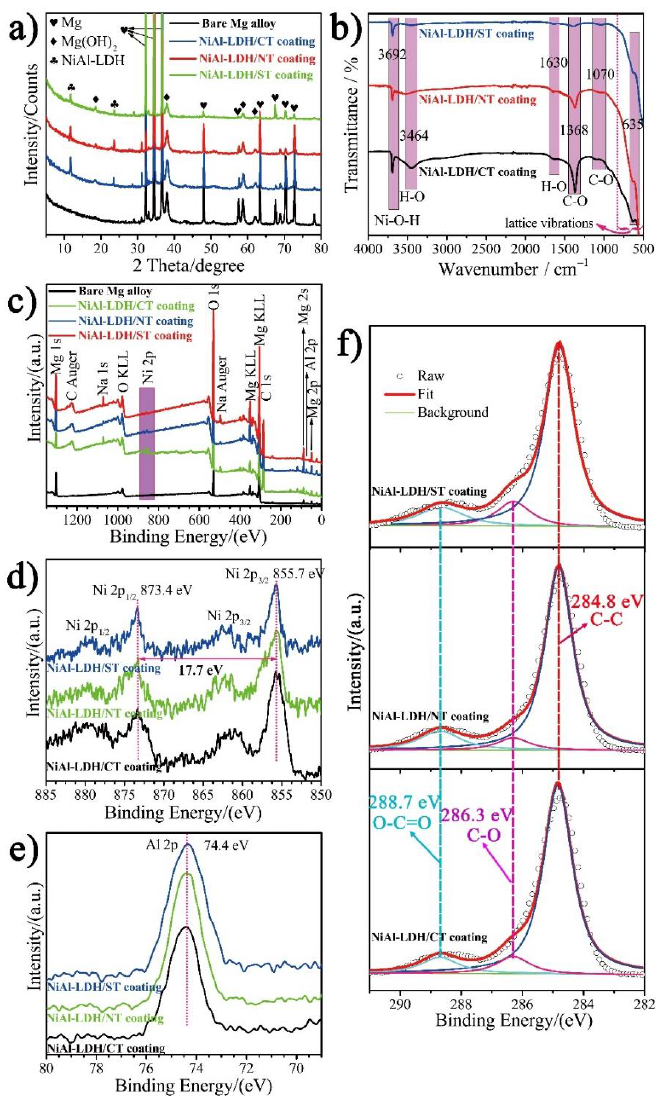
Figure 3. ( a ) XRD patterns; ( b ) FT-IR; and ( c – f ) XPS spectra of different NiAl-LDH coatings.